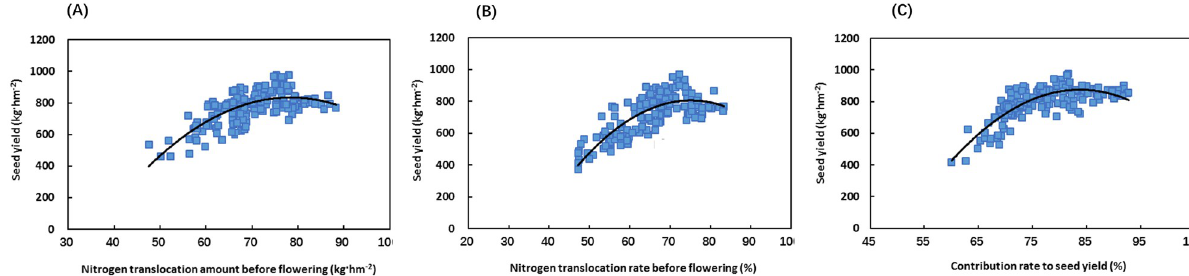
Fig 6. Relationship between nitrogen translocation and seed yield of Chinese milk vetch. (A) Relationship between seed yield and nitrogen translocation amount of vegetative organs before flowering ( Y = -0 . 4571X 2 + 71 . 665X – 1975 . 6 , R 2 = 0 . 494 , P < 0 . 001 , n = 180 ). (B) Relationship between seed yield and nitrogen translocation rate of vegetative organs before flowering ( Y = -0 . 5222X 2 + 78 . 442X − 2140 , R 2 = 0 . 6498 , P < 0 . 001 , n = 180 ). (C) Relationship between seed yield and nitrogen contribution rate of vegetative organs to seed yield before flowering ( Y = -0 . 7965X 2 + 133 . 45X – 4714 . 8 , R 2 = 0 . 6355 , P < 0 . 001 , n = 180 ). All the experiments are